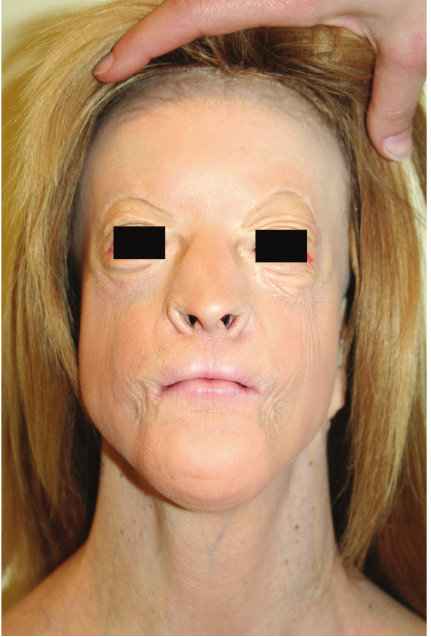
Figure 5: Facial ectodermal alteration.